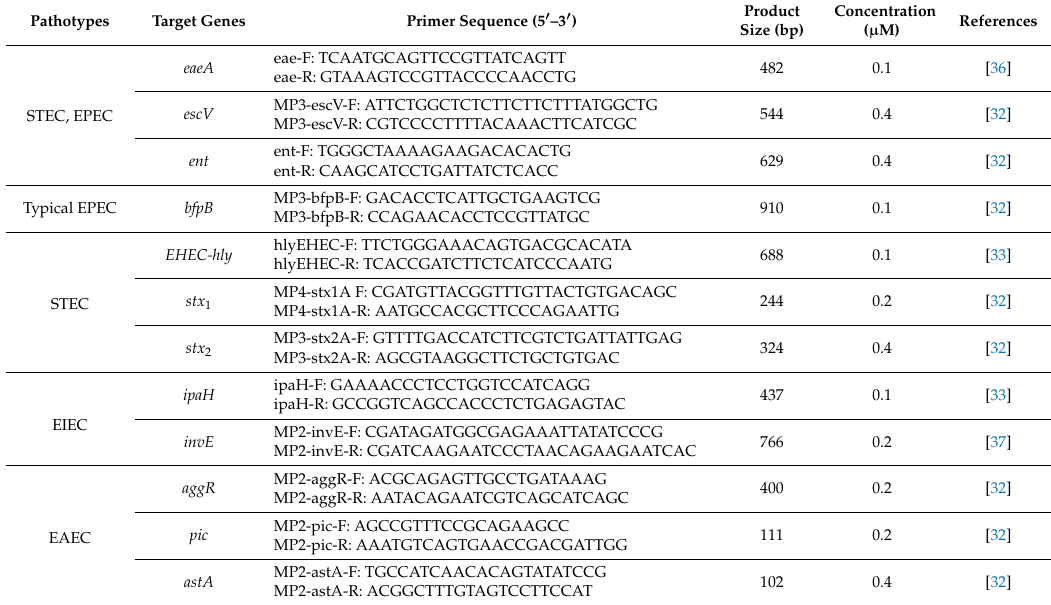
Table 1. 16-Plex PCR primers and the virulence genes